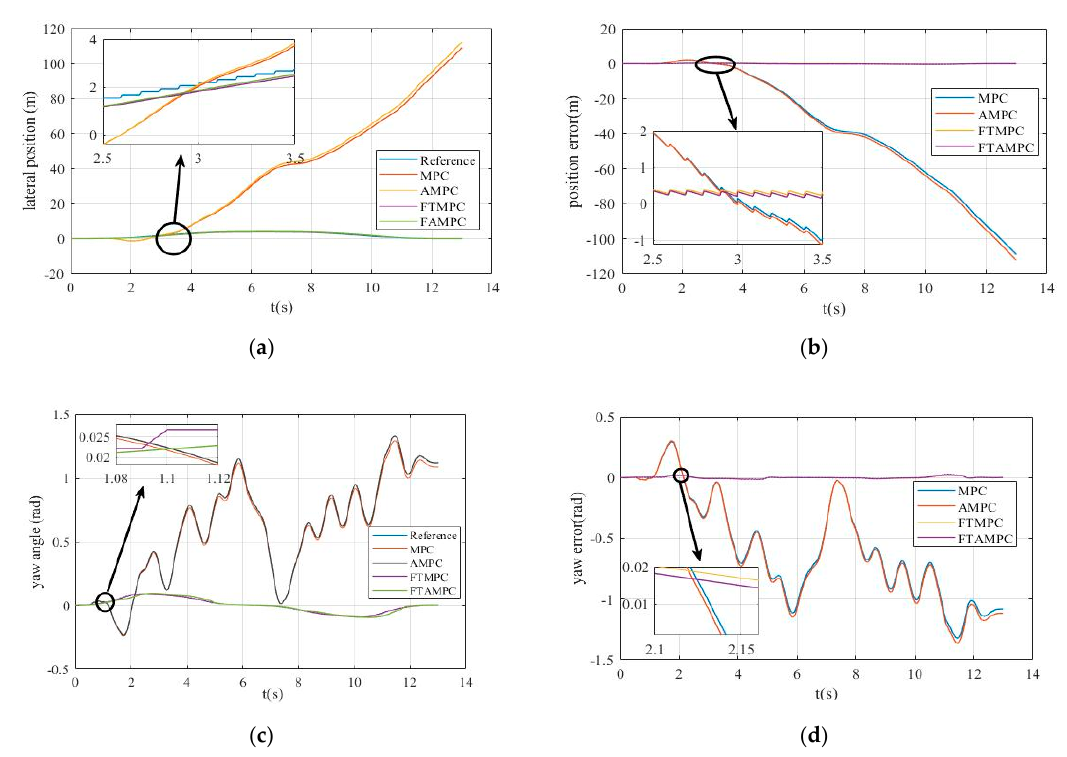
Figure 10. The path tracking control simulation results: ( a ) the lateral position changes; ( b ) the lateral position error before and after fault isolation; ( c ) the yaw angle changes; and ( d ) the yaw angle error before and after fault isolation.